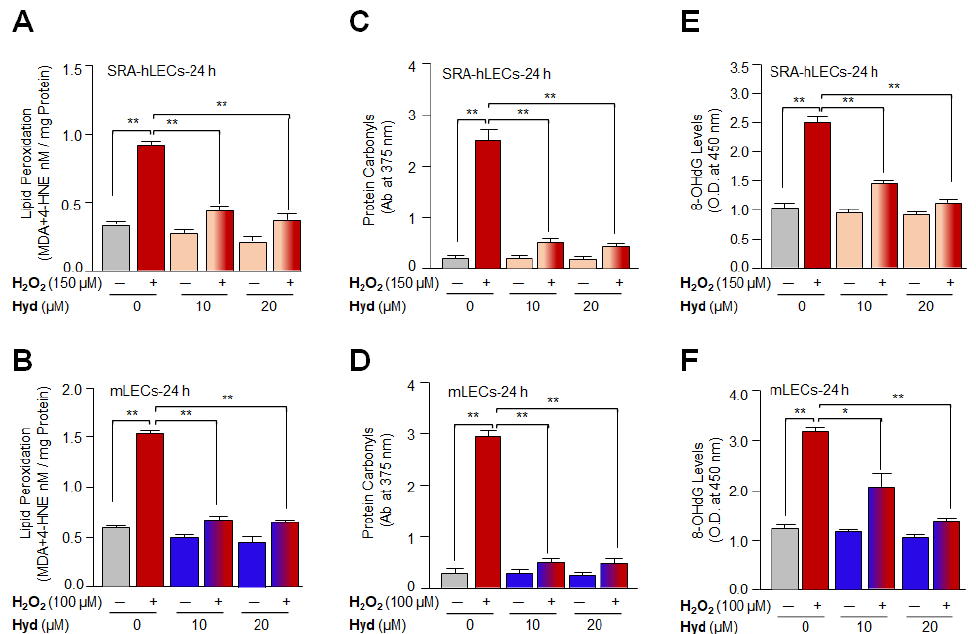
Figure 2. Hyd treatment attenuated H 2 O 2 -induced accelerated production of lipid peroxidation, protein carbonyls, and DNA damage. ( A , B ) Hyd blunted lipid peroxidation in H 2 O 2 -exposed LECs. Hyd-treated or untreated LECs were exposed to H 2 O 2 and then processed for LPO assay. A significant reduction of MDA + 4-HAE levels were observed in Hyd-treated LECs exposed to H 2 O 2 compared to untreated control. Histogram represents the mean ± S.D. of three independent experiments. ** p < 0.001. ( C , D ) Protein carbonyls were measured using 2-DNPH assay in LECs treated with Hyd or H 2 O 2 or Hyd plus H 2 O 2 . Hyd treatment significantly lowered the protein carbonyl levels raised by H 2 O 2 exposure. Histogram represents the mean ± S.D. of three independent experiments. ** p < 0.001. ( E , F ) Hyd treatment blunted oxidative stress-induced DNA damage in LECs. LECs exposed to H 2 O 2 alone or cotreated with Hyd for 24 h were subjected to measure the 8-OHdG levels. Data showed that Hyd attenuated oxidative DNA damage in LECs induced by H 2 O 2 exposure. Histogram represents the mean ± S.D. of three independent experiments. * p < 0.05; ** p <